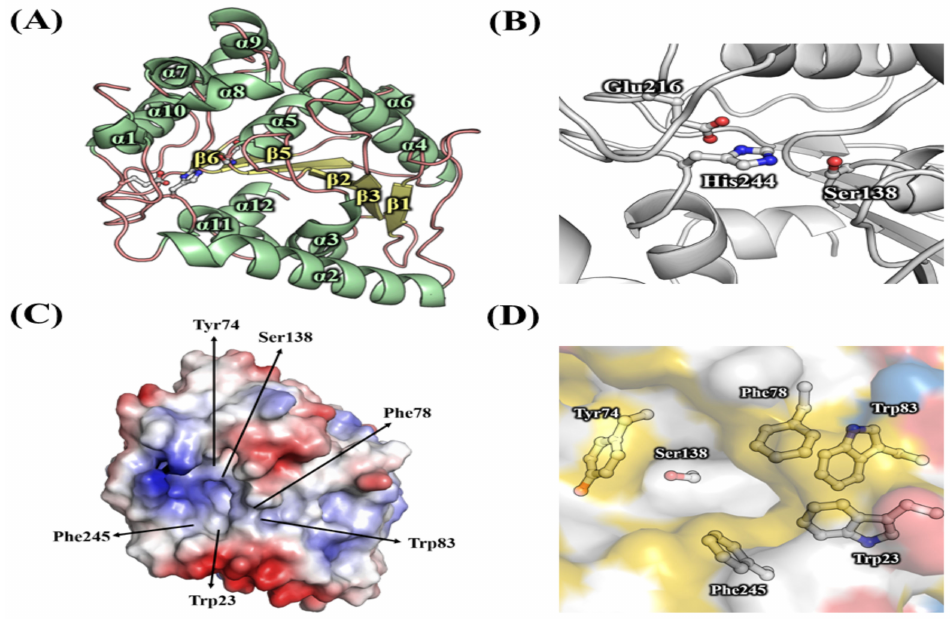
Figure 8. Structural model of Ha HSL. ( A ) The ribbon diagram of the Ha HSL structural model. ( B ) Catalytic amino acids of Ha HSL are shown in a ball-and-stick model. ( C ) Electrostatic representations of Ha HSL. The positions of five aromatic acids are shown in arrows. ( D ) The substrate-binding pocket of Ha HSL. Five aromatic amino acids are shown with a catalytic